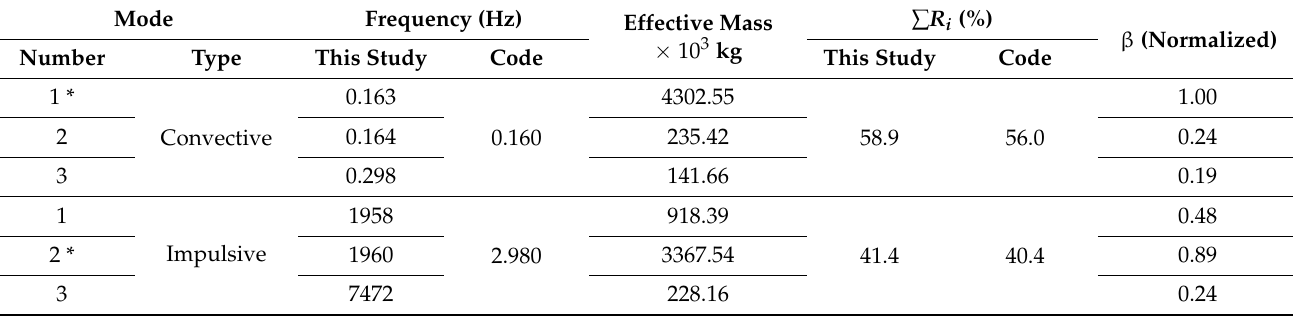
Table 3. Result of the free vibration analysis of the